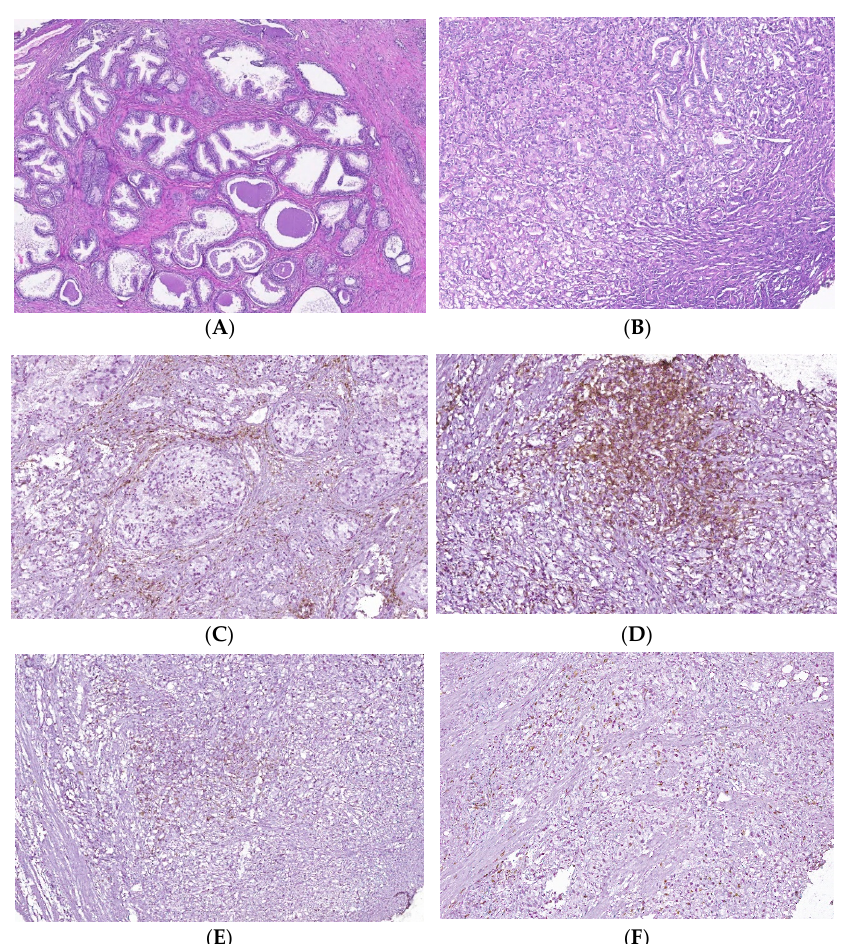
Figure 5. T cell infiltrates from areas of PCa and BPH tissue samples. Legend: ( A ) Microscopic ap- pearance of benign prostatic hyperplasia, usual staining (×20); ( B ) prostate adenocarcinoma, usual